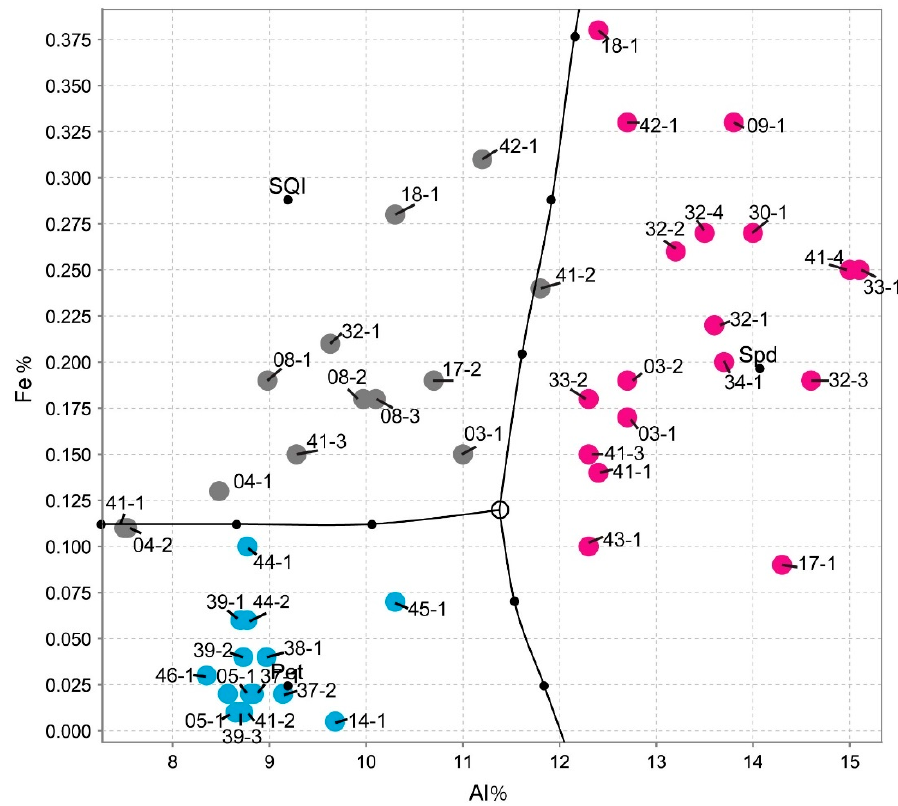
Figure 16. Differentiating spodumene from petalite and from spodumene + quartz mixtures based on the Al and Fe content from the ICP-MS analysis (graph made in the IoGas software with Auto-Domain tool from the analysis tab, with common covariance matrix, coarse accuracy, and no limit in the cutoff M distance). The pink dots are spodumene crystal samples, the grey are mixtures of spodumene and quar tz samples and the blue are petalite crystal samples.